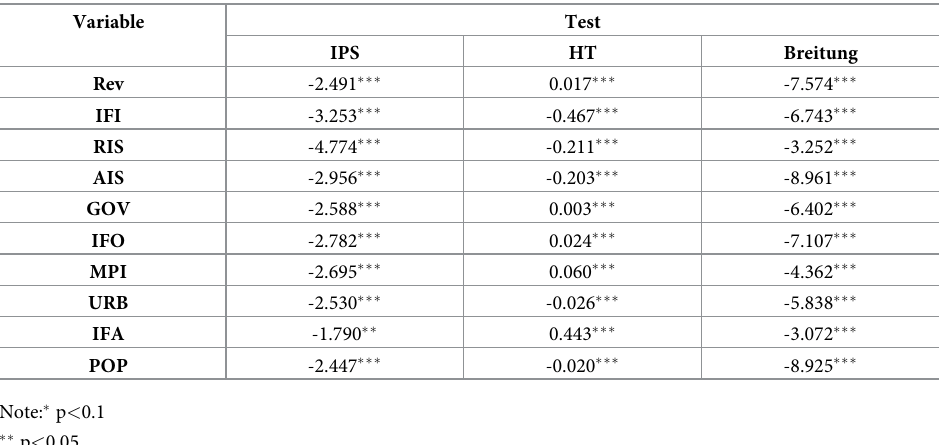
Table 6. First-order difference unit root test.